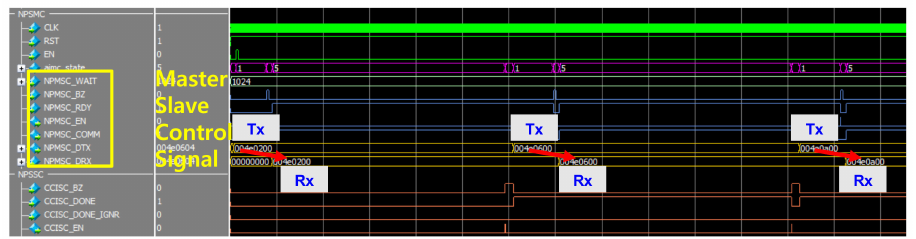
Figure 14. The simulation result of the AIMC control for the biosensor.